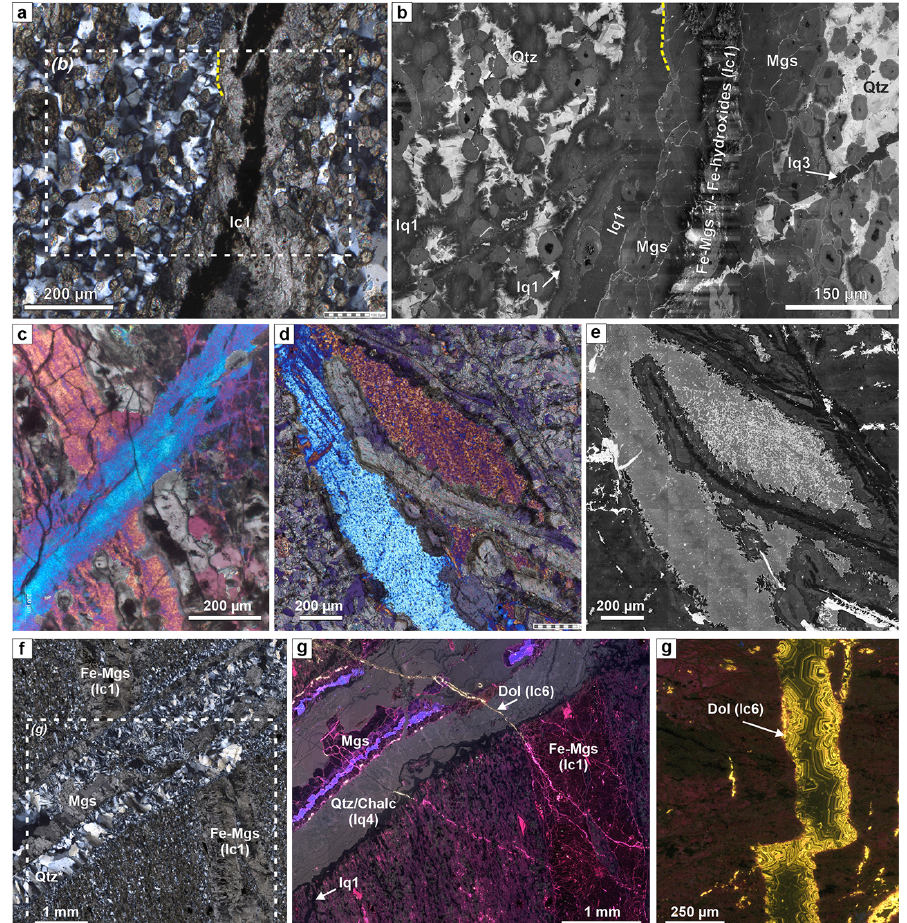
Figure 9. Quartz and late dolomite veins in listvenite. (a) Crossed polarized micrograph of a cryptic quartz vein adjacent to a zoned magnesite vein (lc1). (b) SEM-CL image of the marked area in (a) , showing two generations of dark luminescent cryptic quartz veins (lq1 and lq1 ∗ ) in bright luminescent matrix quartz and exploiting the zoned magnesite vein interface. Cryptic quartz veins do not cut magnesite ellipsoids in the matrix. A later quartz vein (lq3) cuts both magnesite ellipsoids and the zoned magnesite vein. (c) Two cross-cutting generations of microcrystalline quartz veins with distinct crystal preferred orientations (xpol with 1 λ plate). (d, e) Cross-cutting relationship between zoned magnesite veins and microcrystalline quartz ( d : ViP xpol with 1 λ plate; e : SEM-CL); dendritic magnesite overgrowths on the carbonate vein are undisturbed by the microcrystalline quartz. (f, g) Crossed polarized micrograph and optical CL mosaic image of a quartz–magnesite vein (lq4), with chalcedony cutting a zoned magnesite vein. Magnesite in the vein has luminescence distinct from that in the listvenite matrix. A late, thin dolomite vein cuts all other vein generations. (g) Optical CL mosaic image of a late syntaxial lc6 dolomite vein in listvenite, showing dull to bright yellow oscillatory growth zoning into an open fracture. The vein is roughly oriented vertical (parallel with respect to the core orientation) ( a, b, f, g : sample BT1B_14-3_77-80, see marked areas in Fig. 7a, c: BT1B_56-4_45-50; e, f : BT1B_67-2_36-40; g :